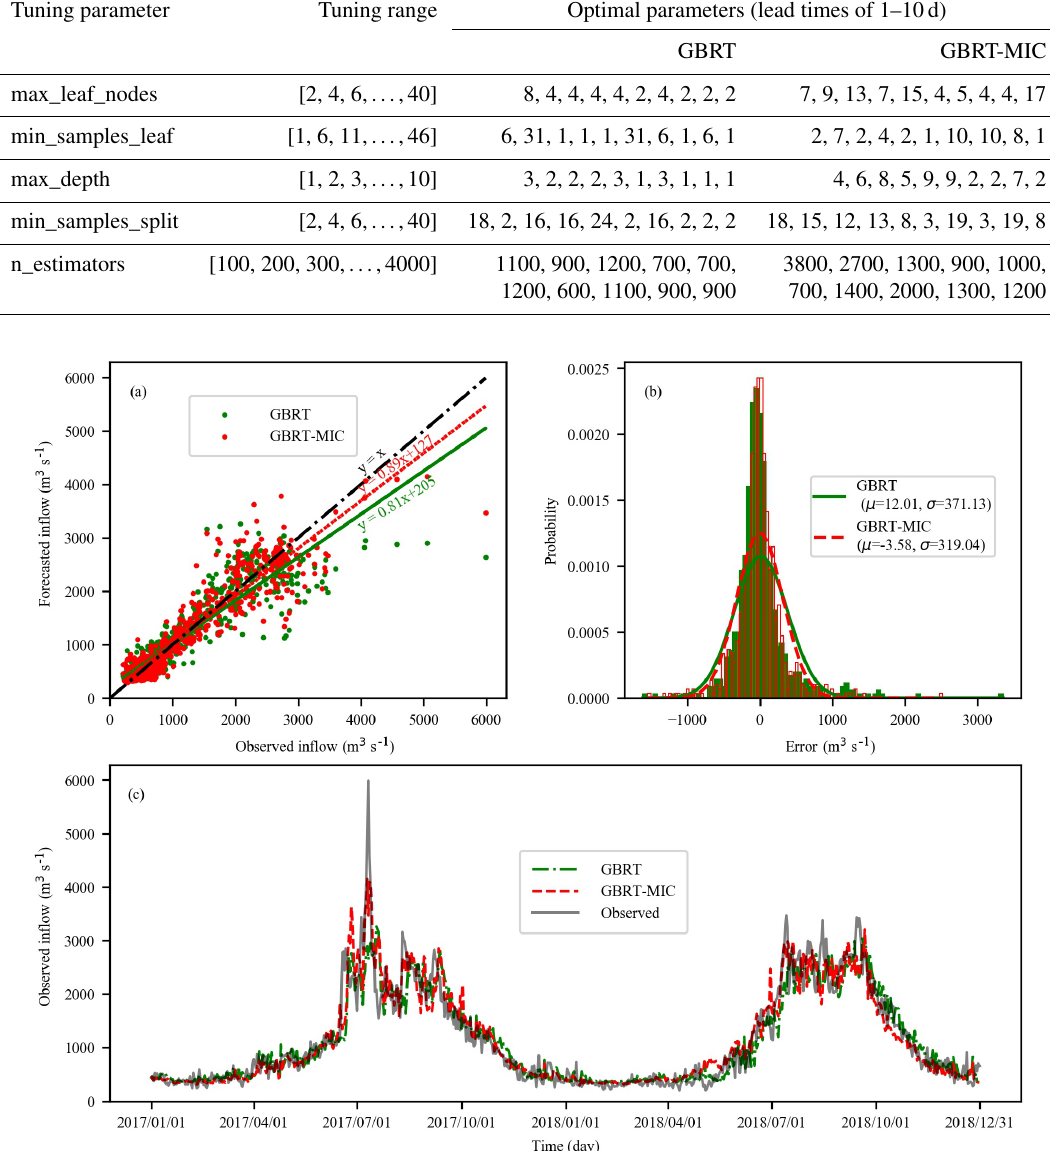
Table 6. Tuning parameters for GBRT and GBRT-MIC. Tuning parameter Tuning range